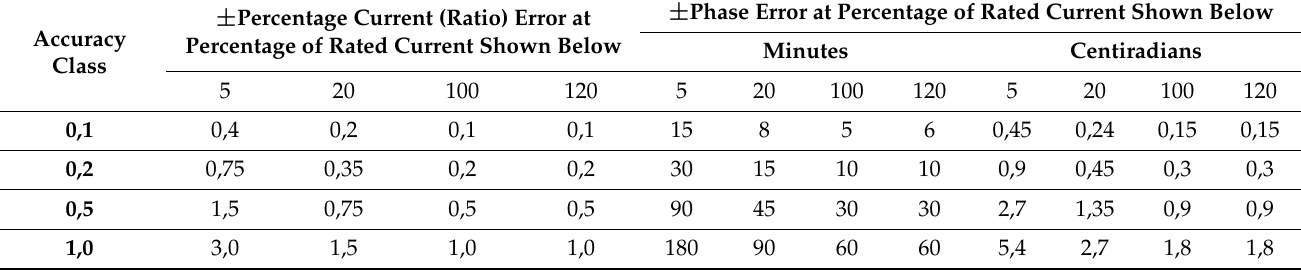
Table 1. IEC metering class specifications.